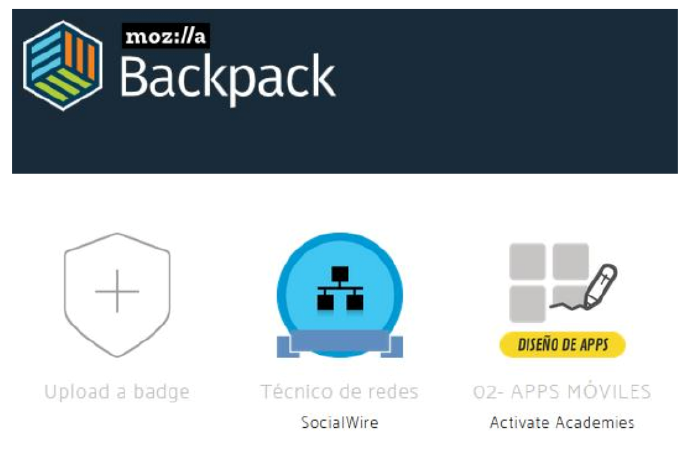
Figure A2. Generation of certificates that are compatible with Open Badges.